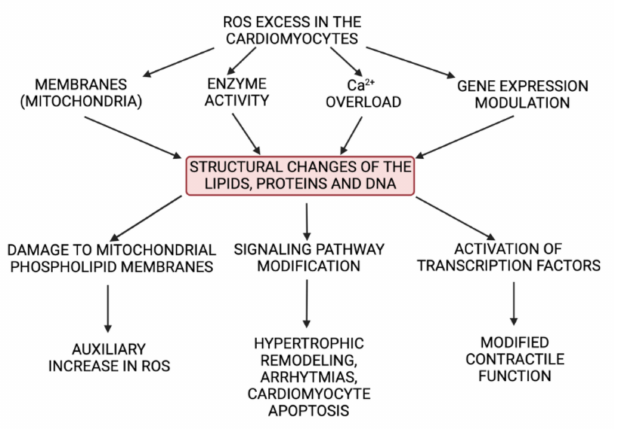
Figure 2. Harmful effects of ROS in cardiomyocytes (created with BioRender.com on 11 February